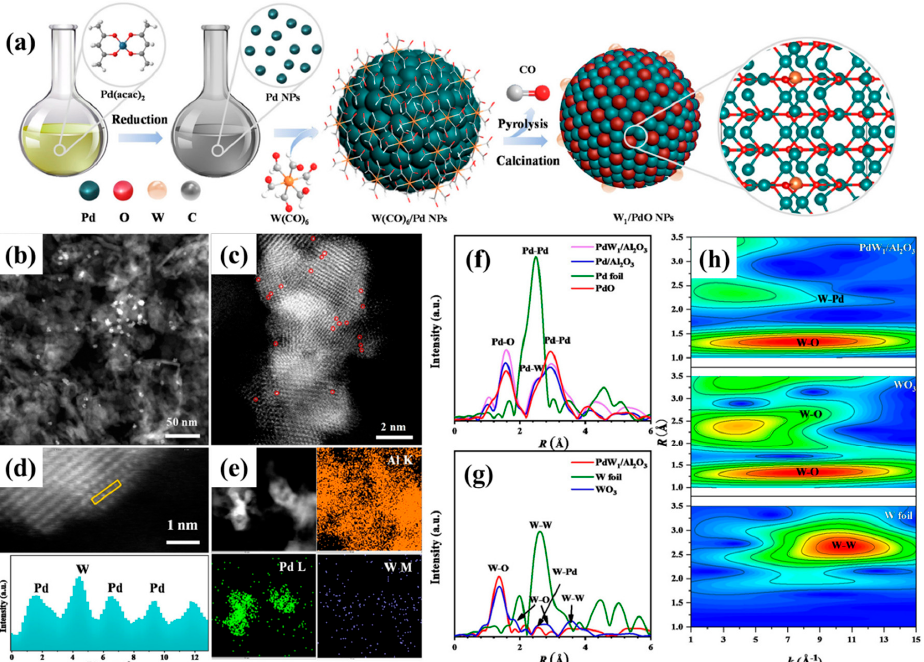
Figure 13. ( a ) Illustration of the preparation process of PdW 1 /Al 2 O 3 , HAADF-STEM images, and particle-size distributions (insets) of ( b ) PdW 1 /Al 2 O 3 ; ( c , d ) aberration-corrected HAADF–STEM images and ( e ) EDX elemental mappings of PdW 1 /Al 2 O 3 . The Fourier transforms of the experimental EXAFS spectra of the as-obtained samples at the ( f ) Pd K-edge and ( g ) W L 3 -edge; ( h ) wavelet transform plots of PdW 1 /Al 2 O 3 , WO 3 , and W foil. Reprinted with permission from Ref. [108]. Copyright 2022, copyright John Wiley and Sons.